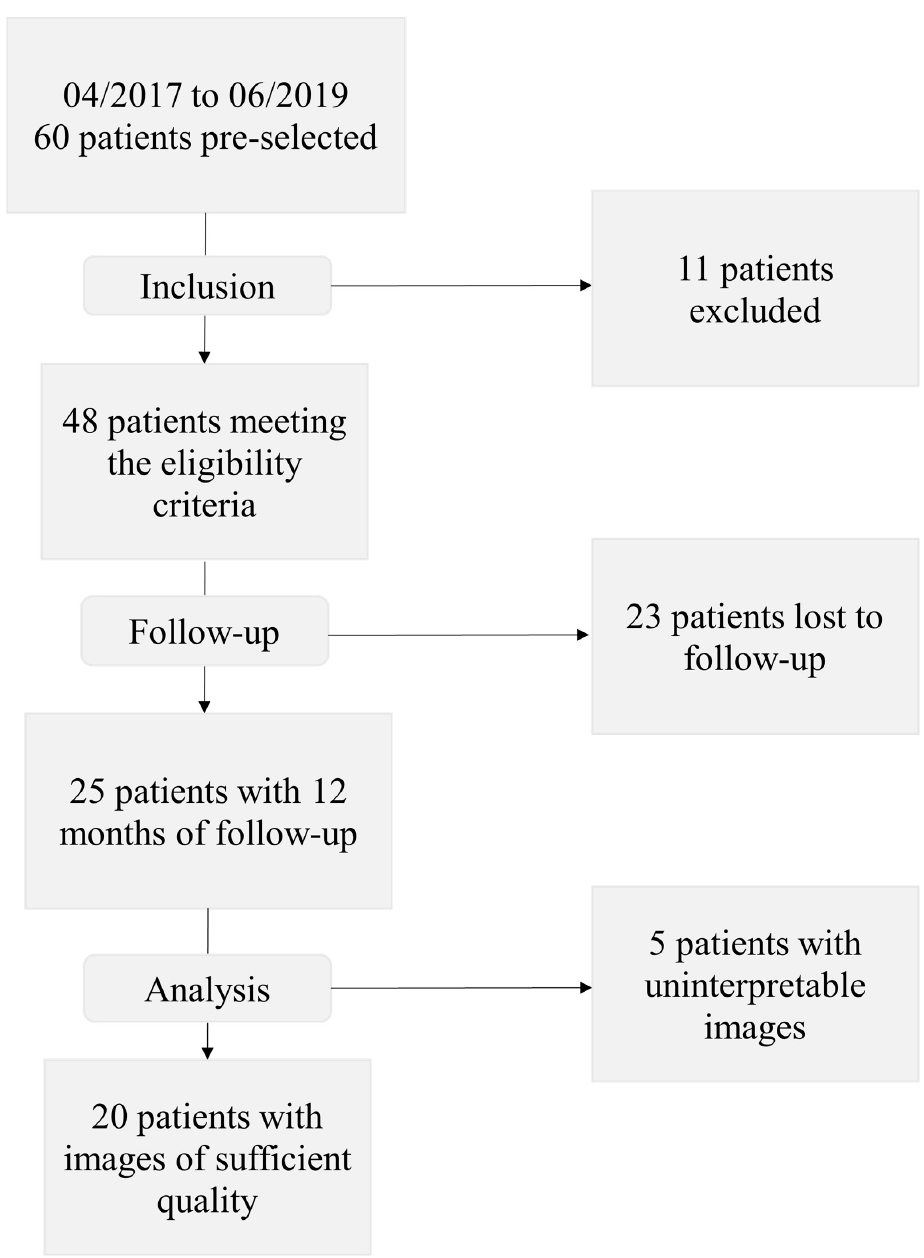
Figure 3. Study flowchart.